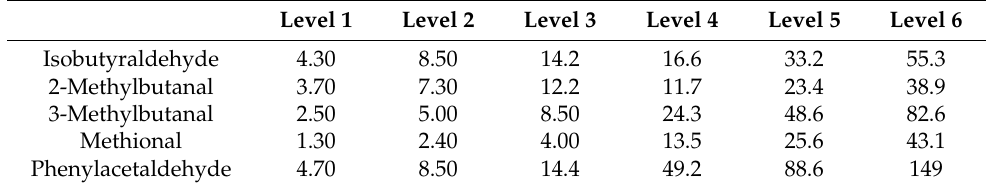
Table 2. Strecker aldehydes concentrations ( µ g/L) in wine models without sulphur